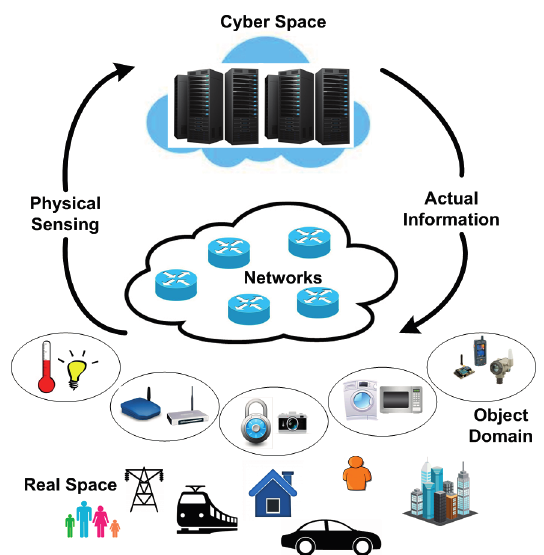
Figure 3. Cyber physical system applications with interconnecting boundary between cyber and object